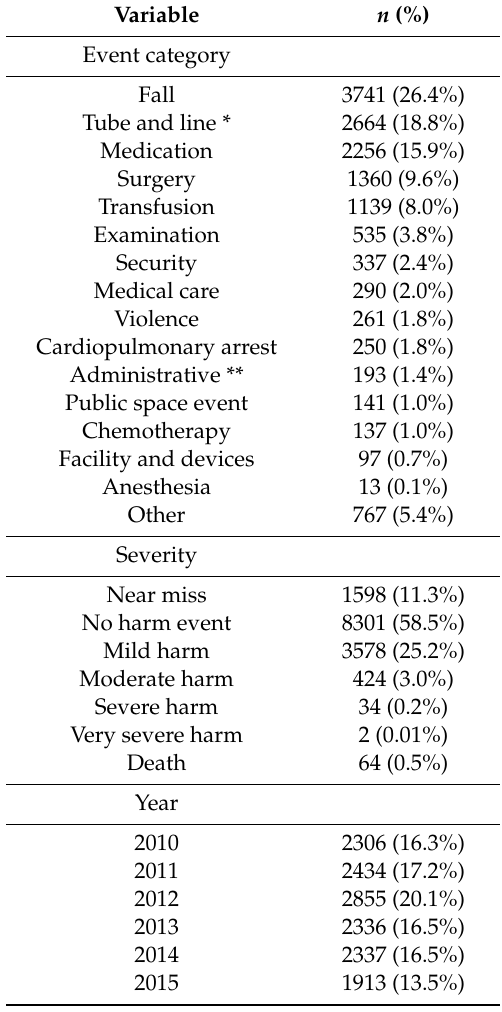
Table 2. Summary of category and severity of patient safety events ( n =